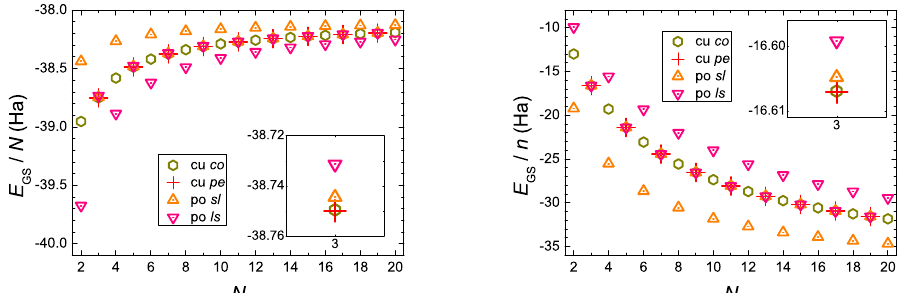
Figure 7. “Ground state” energy, E GS , of molecules with a hole created at its first site, B3LYP/cc-pVTZ level of theory. N is the number of carbon atoms, n is the number of all atoms, cu co and cu pe denote cumulenic molecules with coplanar and perpendicular methylene groups, respectively; po sl and po ls denote polyynic molecules starting with short and long bonds, respectively. The insets emphasize that, for odd N , the cu pe and cu co molecules come closer in energy (it seems that for N > 3 cu co has slightly lower energy), po sl has higher energy and po ls still higher.